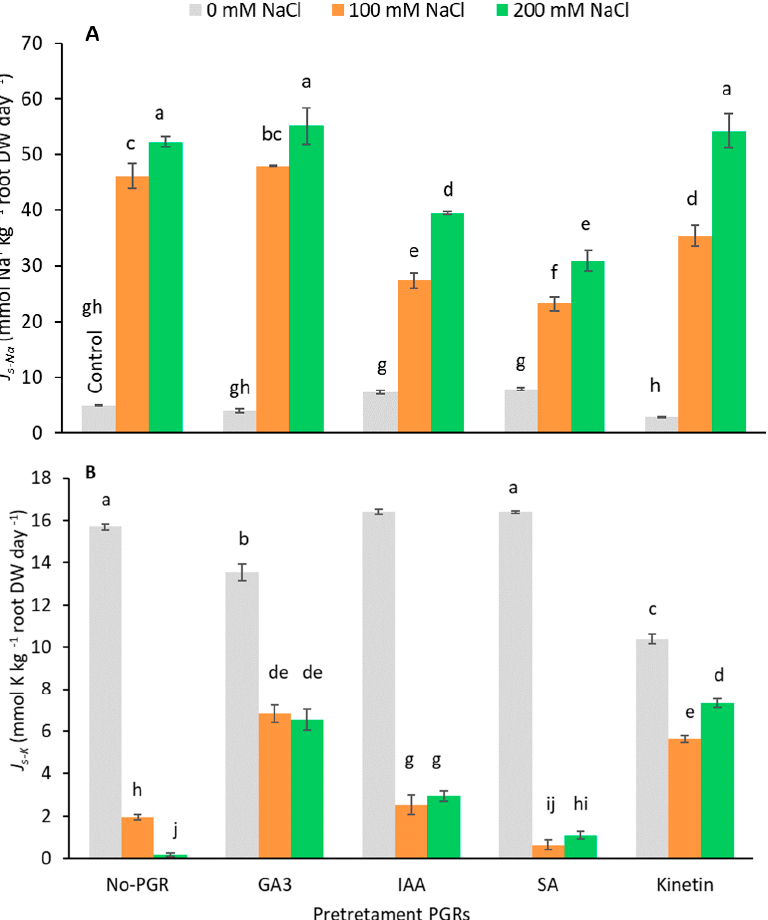
Figure 3. Effect of salt stress on net translocation rates of Na + ( A ) and K + ( B ) from root to leaves of Olea europaea plants pretreated with plant growth regulators (PGRs). Data are expressed as mean ± SE (n = 4). Means followed by the same letter are not significantly different according to the LSD test ( p <